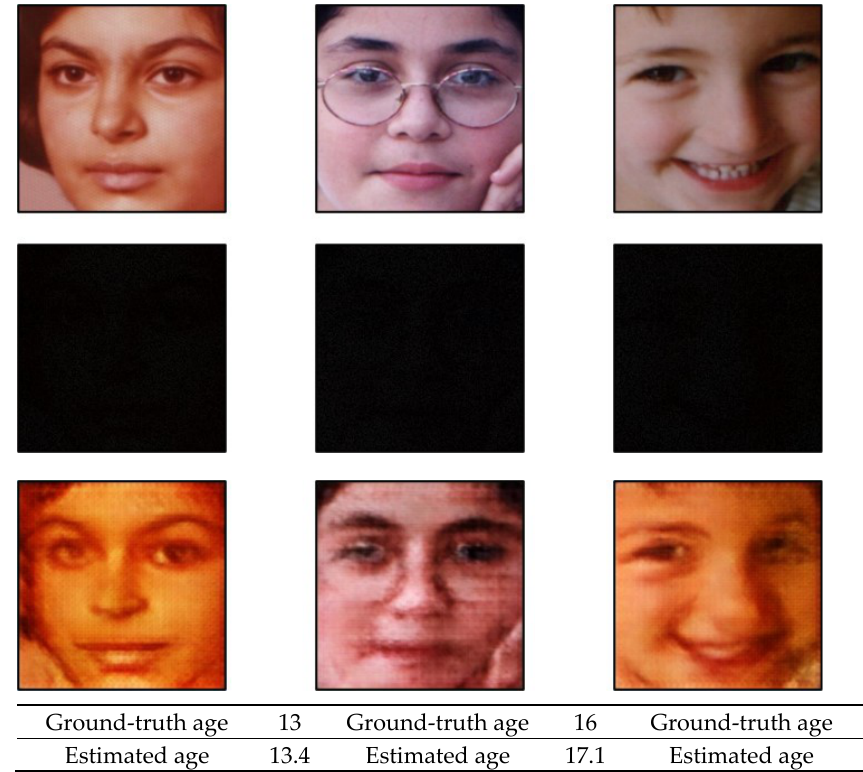
Figure 13. Good cases of age estimation by the proposed method. The 1st, 2nd and 3rd rows show the original images, low-illuminated images, and the images enhanced by LAE-GAN, respectively.